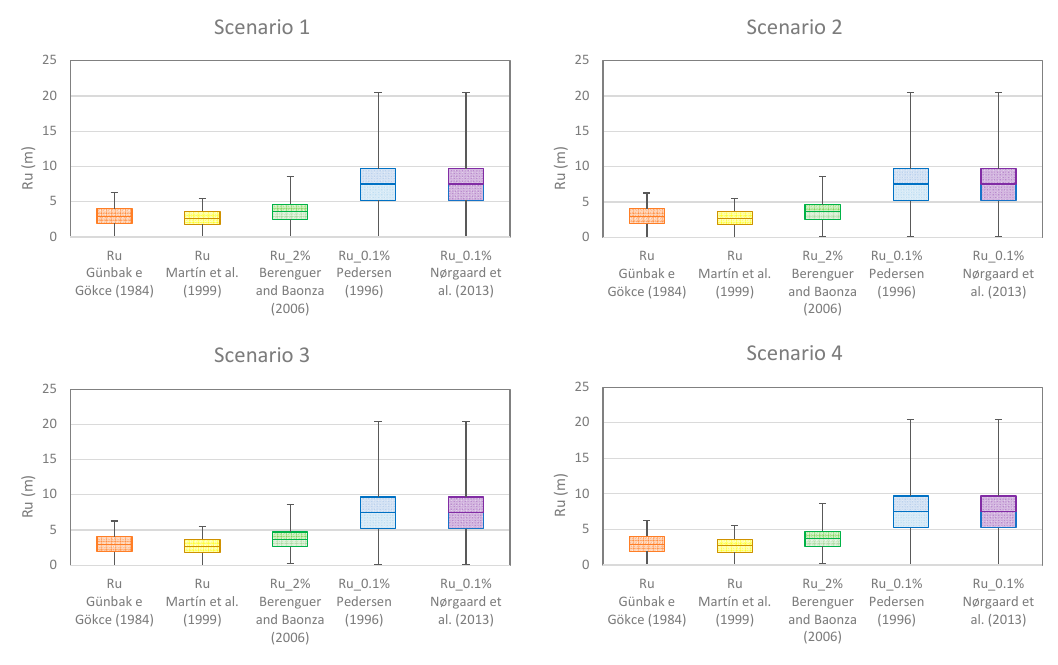
Figure 20. Results of the run-up for the different formulas for scenarios 1–4. Figure 21 allows to compare the values of horizontal pressures for the 4 equations